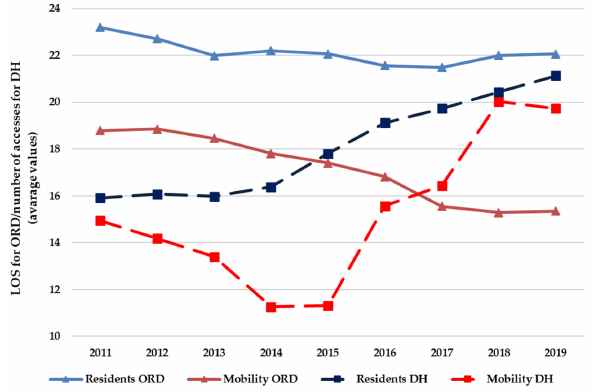
Figure 1. Average values of LOS for ORD and for the number of accesses for DH, for hospital orthopedic intensive rehabilitation (residents and mobility), from 2011 to 2019. Figure 2 shows the NdG of every Italian region for hospital orthopedic intensive re- habilitation from 2011 to 2019. For the studied time periods, all regions were in the upper right quadrant. However, only six regions (Piedmont, Lombardy, A.P. of Trento, E. Ro- magna, Umbria and Abruzzo) were in the hemi-quadrant of quality. Tuscany appears in the upper left quadrant and then under the bisector in the upper right quadrant. A.P. of Bolzano and Molise lost their positions. Aosta Valley had initially crossed the bisector and then returned to the starting hemi-quadrant. Attractions increased ( p < 0.05) for Lom- bardy, A.P. of Trento, Veneto and Basilicata, while they decreased ( p < 0.05) for A.P. of Bolzano, Veneto, F.V. Giulia, Abruzzo, Calabria, and Sicily. Escapes increased ( p < 0.05) for Veneto, F.V. Giulia, E. Romagna, Tuscany, Molise, Puglia and Basilicata, while they decreased ( p < 0.05) for Piedmont, Aosta Valley, A.P. of Trento, Umbria, Abruzzo and Sicily.